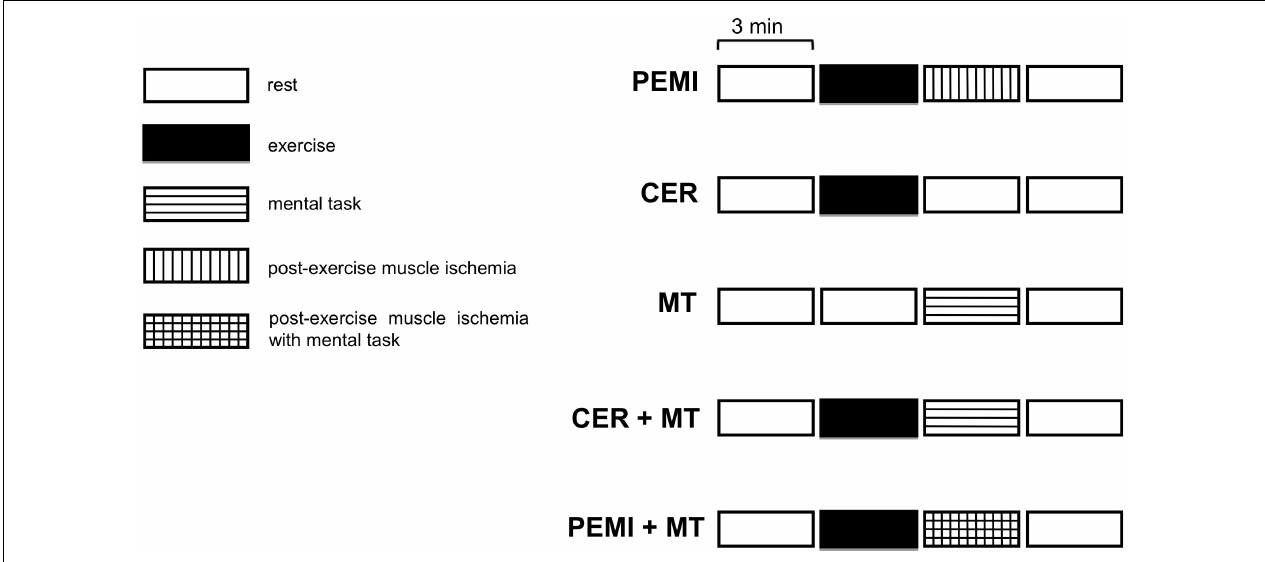
FIGURE 1 | Schematic representation of the various sessions of the study protocol. PEMI, post-exercise muscle ischemia; CER, control exercise recovery; MT, mental task; CER + MT, control exercise recovery + mental task; PEMI + MT, post-exercise muscle ischemia + mental task.